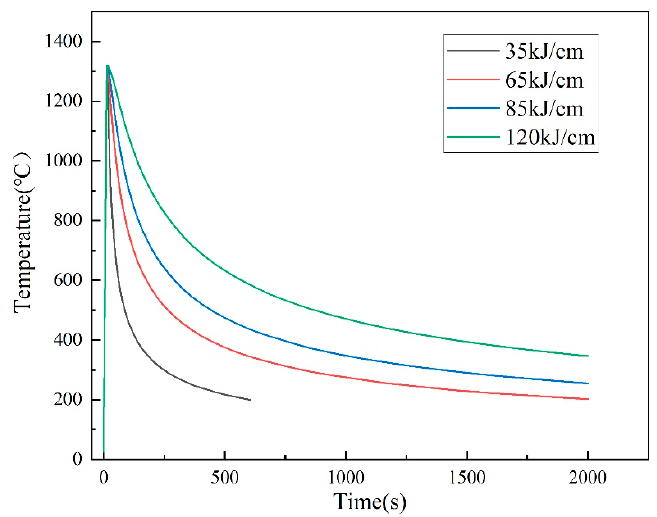
Figure 1. Schematic diagram of the procedures of the thermal processing simulations. The simulated samples were processed into the micro-tensile samples as shown in Figure 2. The micro-scale tensile test was performed on the Inspekt Table 5KN model general testing machine (Hegewald&Peschke, Freiberg, Germany) with an extension rate of 1 mm/min at room temperature [29]. Two tensile samples with the same typical microstructures formed at each heat input were prepared and averaged. Since the tensile curve had no yield platform, 0.2% offset stress was taken as the yield strength.